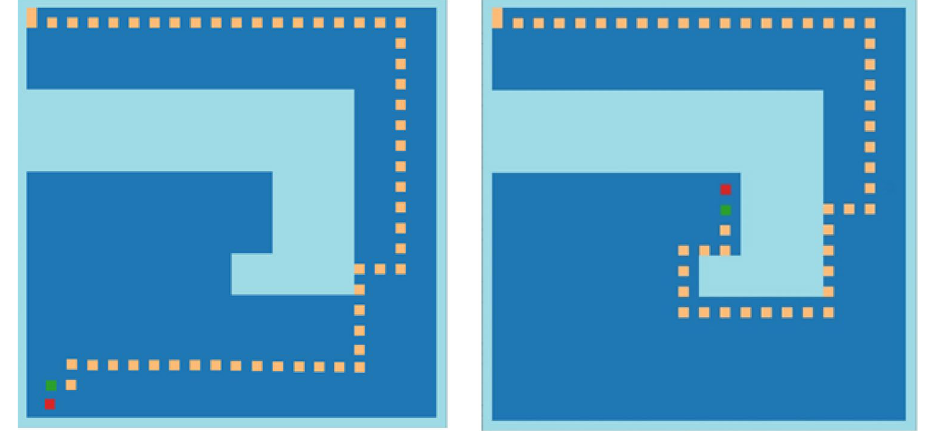
Figure 7. Examples of routing performed by the proposed